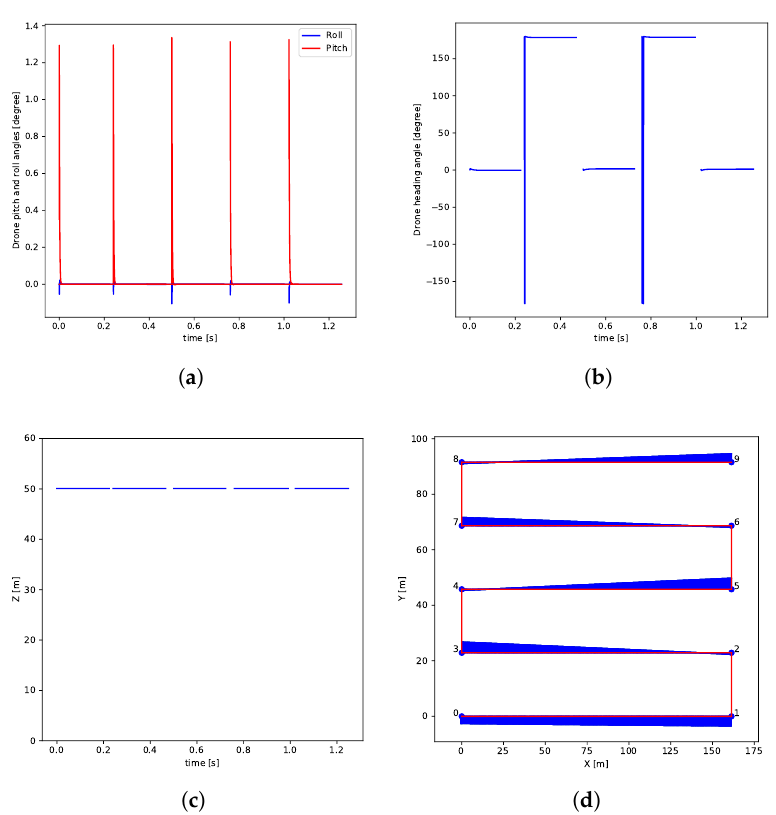
Figure 12. Mission flight data. ( a ) Drone pitch and roll angles; ( b ) drone heading angle; ( c ) drone altitude above ground; ( d ) drone